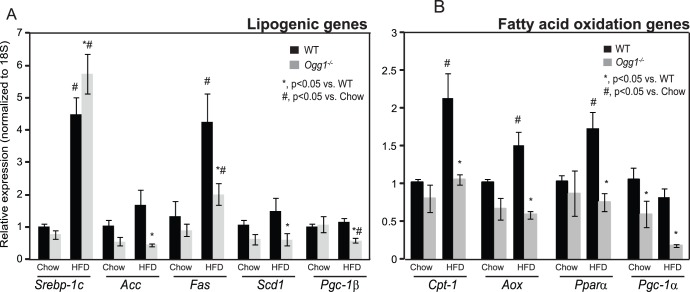
Hepatic lipogenic and fatty acid oxidation gene expression.Expression of key genes involved in hepatic lipogenesis (A) and fatty acid oxidation (B) were measured by qRT-PCR. n = 6 in each group; *, p<0.05 vs. WT, #, p<0.05 vs. chow-fed mice.